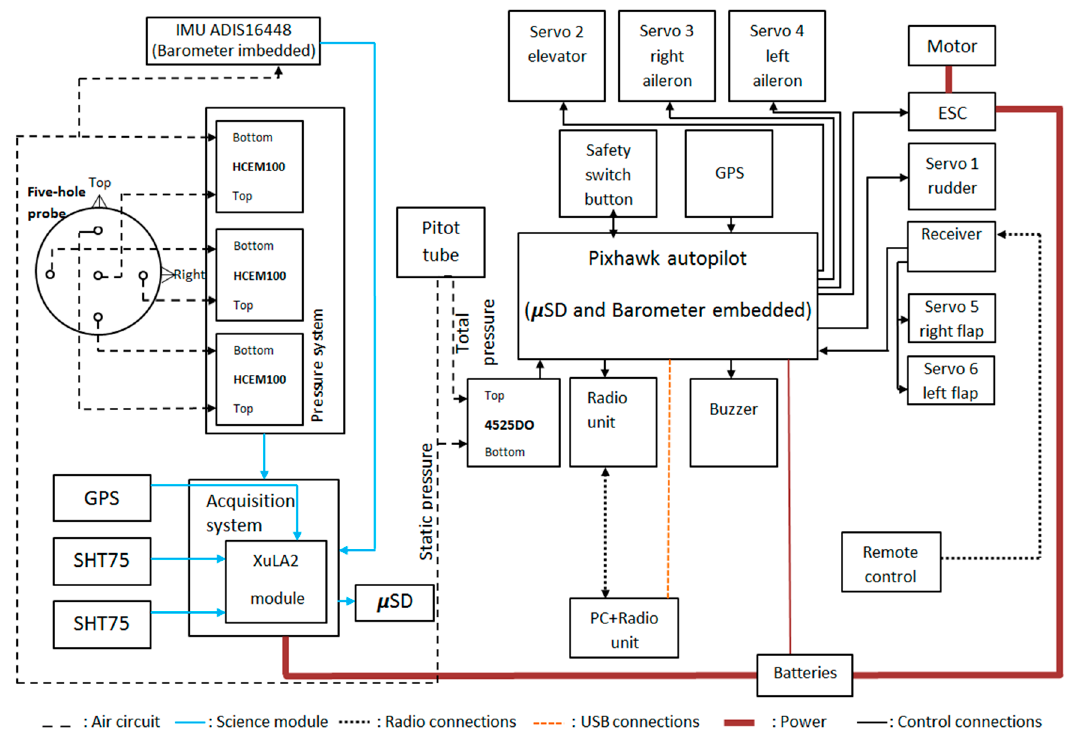
Figure 3. Diagram of connections between different devices on OVLI-TA.